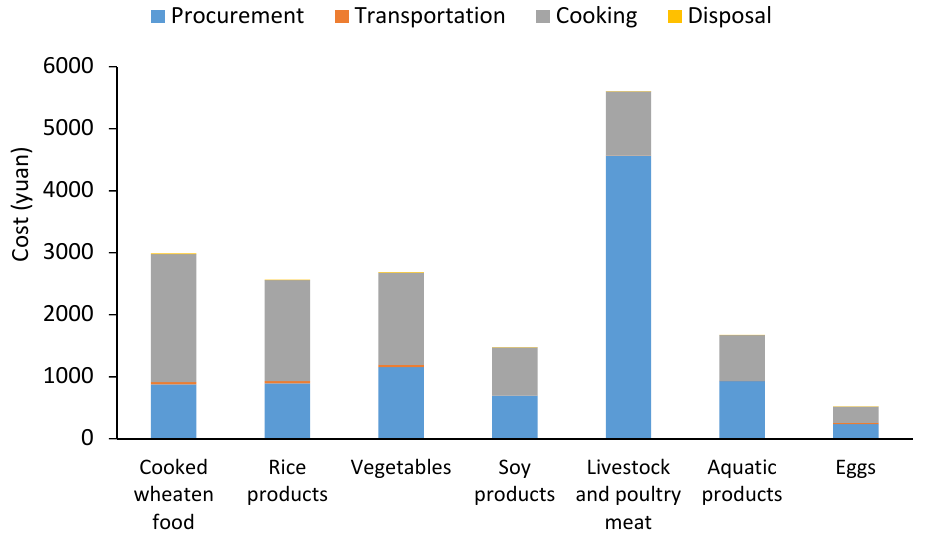
Figure 3. Distribution of cost of food waste in university canteens.